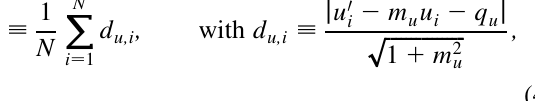
FIG. 5. Simulated spatiotemporal distribution ð z; x Þ at s ¼ 0 : 47 m (a) and s ¼ 3 : 77 m (b) (corresponding to X3 screen) w.r.t. to the photocathode and associated longitudinal charge distributions [(c) and (d), respectively]. The charge is 250 pC and the rms laser transverse size is (cid:2) c ¼ 1 mm . In these plots the tail of the bunch is at z > 0 .